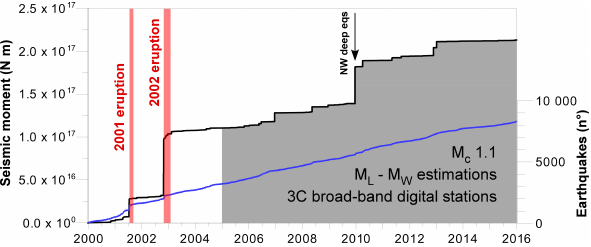
Figure 3. General trend of seismicity at Mt. Etna from 2000 to 2015: the black line indicates the cumulative seismic moment (calculated according to Kanamori, 1977), and the blue line shows the number of earthquakes. The periods marked in red indicate the main flank eruptions; in gray, the time span selected for the analy- sis. Note that the step in the seismic release at the end of 2009 is related to a seismic sequence in the NW sector of the volcano at a depth of 24–28km, not affecting the characterization of the shallow